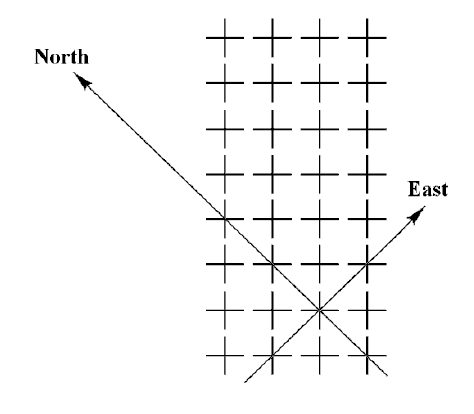
Fig.1. The MF-radar antenna array layout.